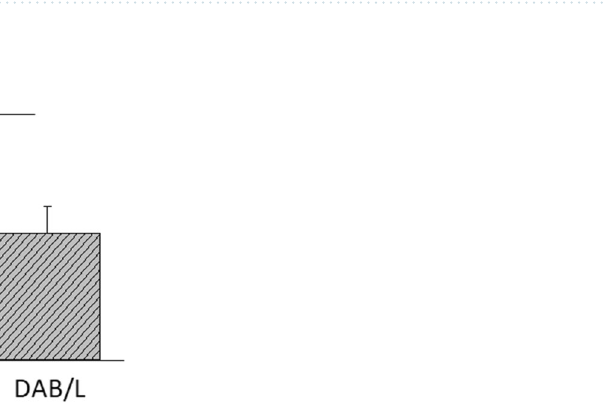
Figure 4. Effects of lactate on VMN astrocyte amino acid concentrations following administration of DAB. Data show mean Asp ( A ), Gln ( B ), Glu ( C ), Cre ( D ), and GABA ( E ) concentrations ± S.E.M. for V/V (solid white bars); DAB/V (solid gray bars); and DAB/Lactate (diagonal-striped gray bars) treatment groups. * p < 0.05, ** p < 0.01, *** p < 0.001.